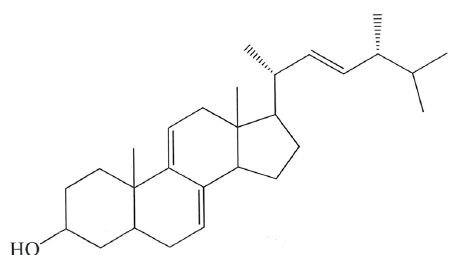
Figure 7. The structure of Ergosta-7,9(11),22-trien-3 β -ol from Antrodia camphorata (EK100), molecular weight = 396.65.